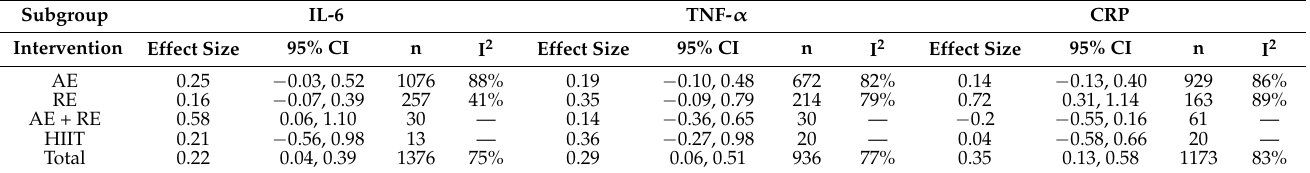
Table 3. Subgroup analysis of the effect of different modes on inflammatory response in the